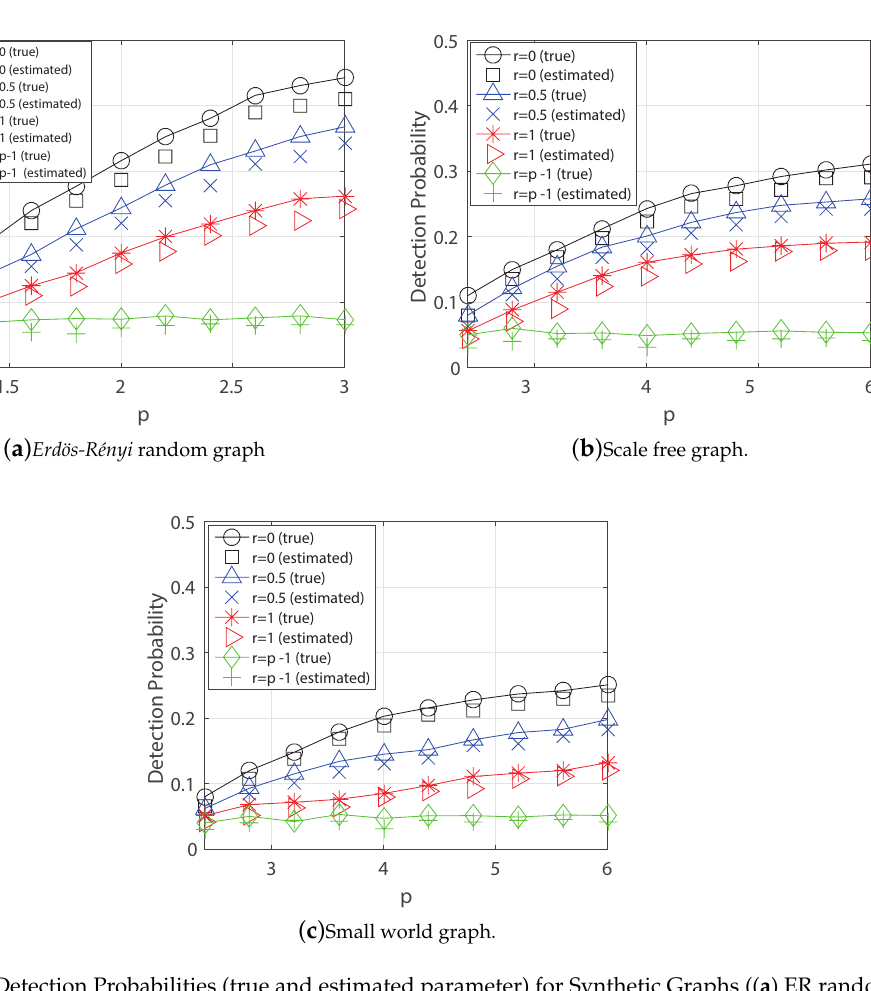
Figure 6. Detection Probabilities (true and estimated parameter) for Synthetic Graphs (( a ) ER random graph, ( b ) Scale Free graph, and ( c ) Small World graph ( K =